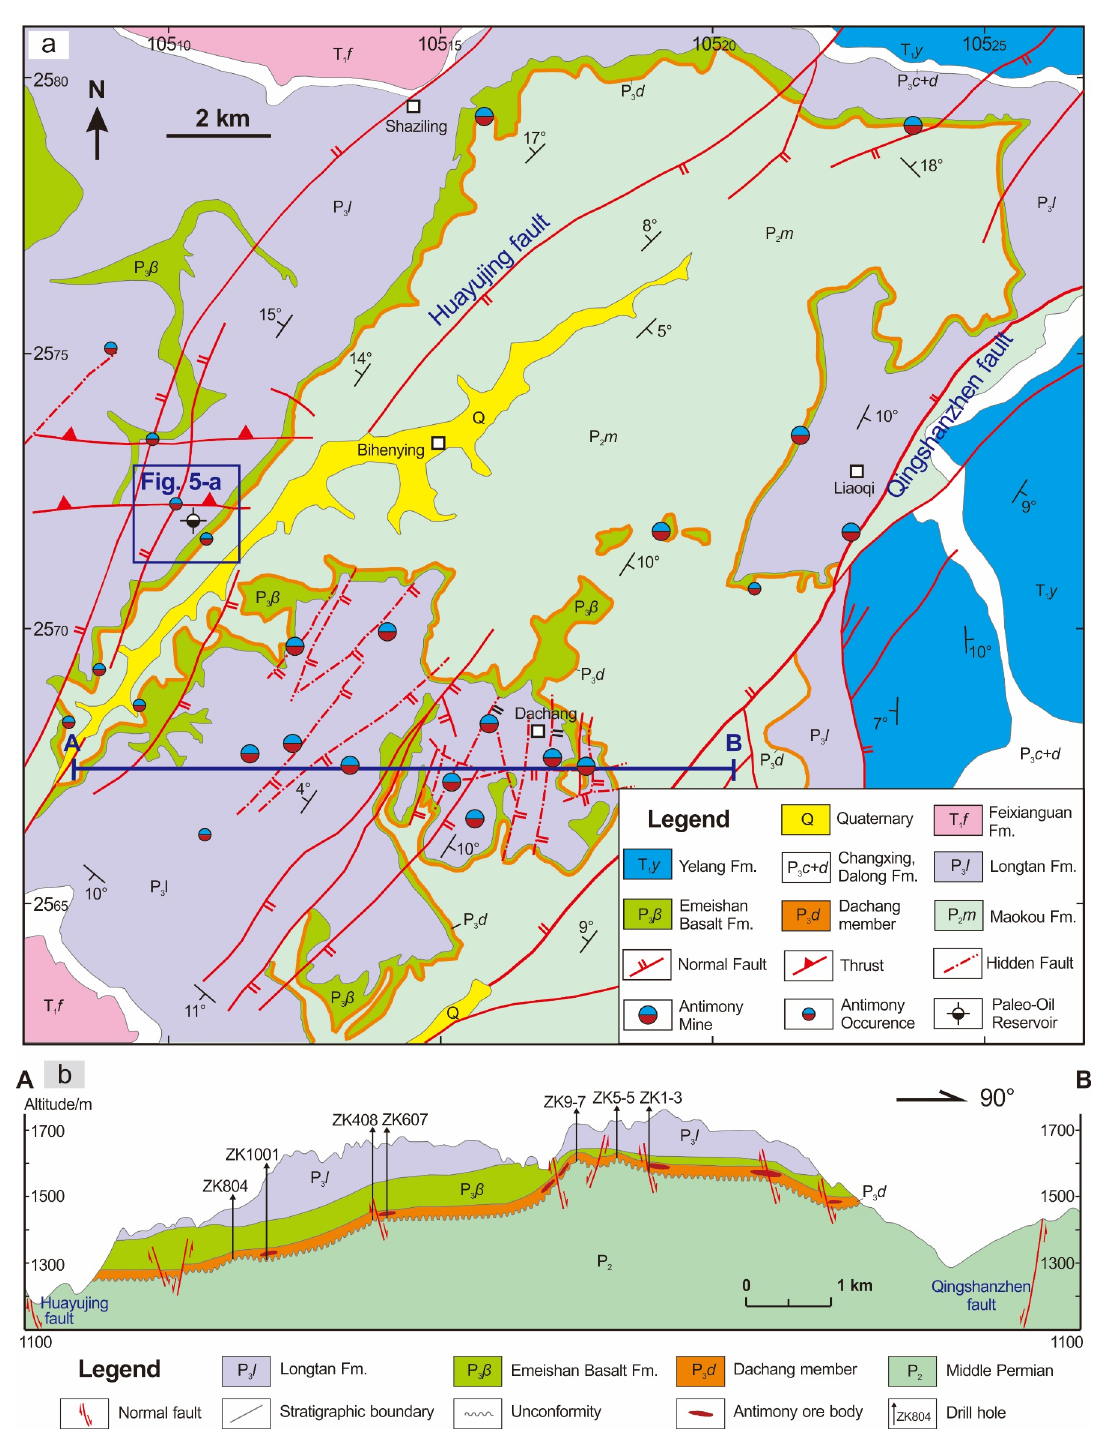
Figure 3. Geological map of Qinglong antimony ore field ( a ) and geological section map ( b ) (modified after [ 38 ]).